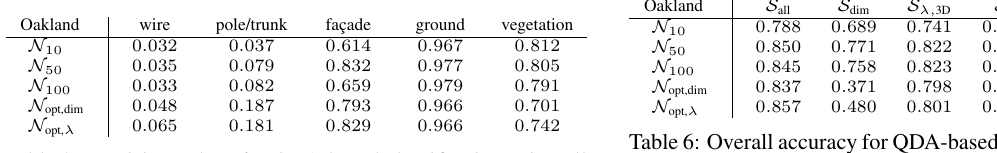
Table 3: Precision values for QDA-based classification using all features and different neighborhood definitions.